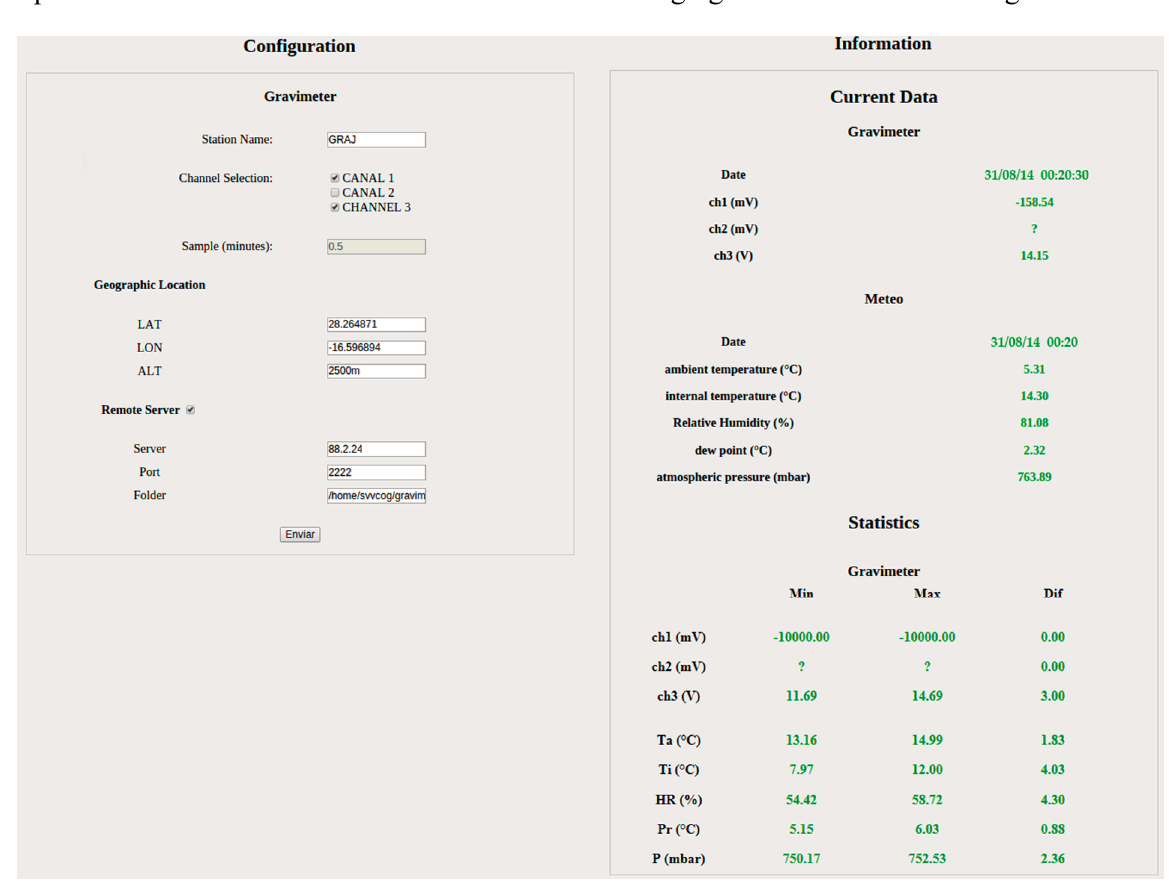
Figure 5. Image captured from the website corresponding to the gravimeter configuration section and metadata. Left-hand side: the configuration data; right-hand side: information regarding the gravity meter system, battery, and meteorological data.